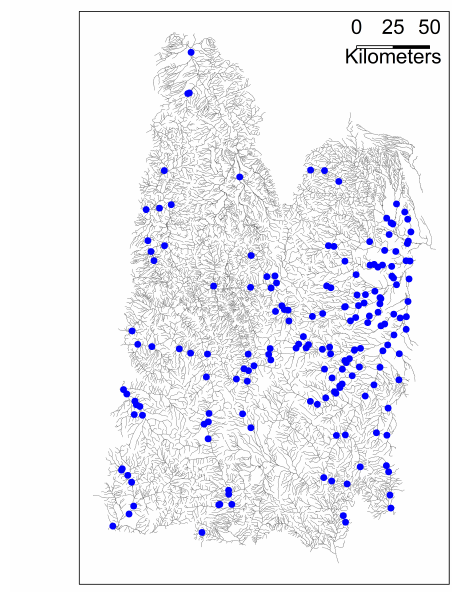
Figure A9. Wastewater point source locations (blue dots) for the stream network of interest (gray